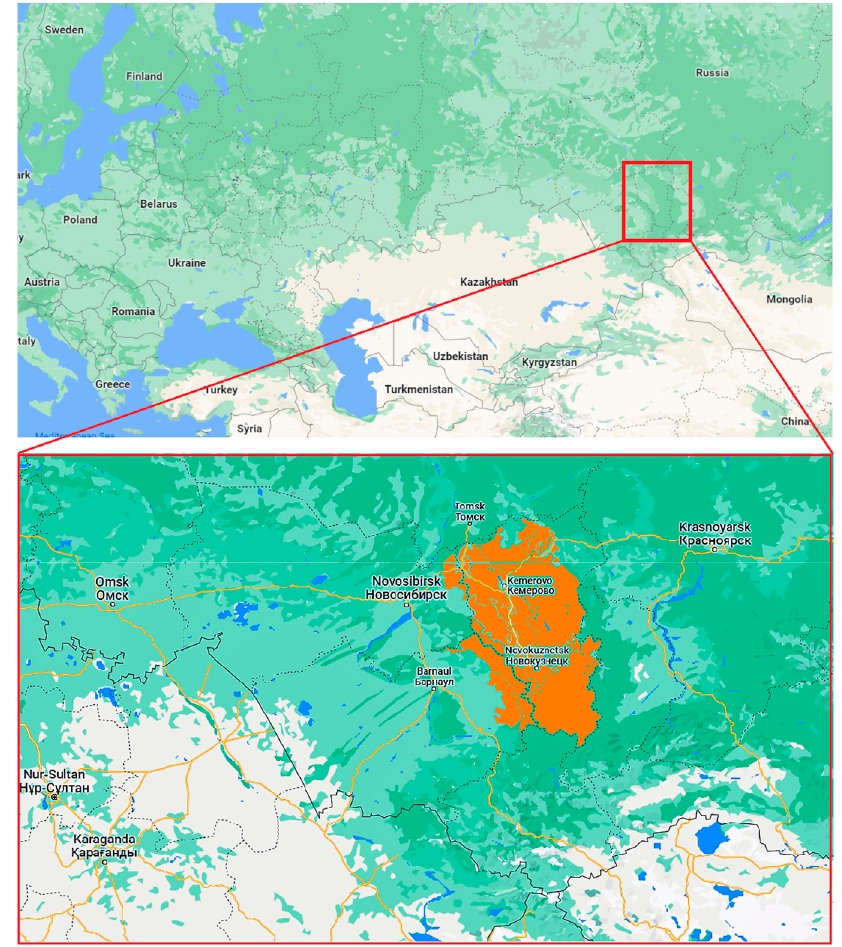
Figure 1. Kemerovo region, Russia. Map provided by Google Maps.